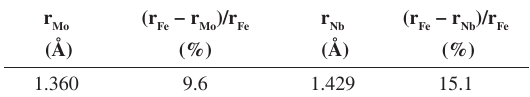
Table 1. Atomic radius of the elements (r size mismatch with the Fe atomic radius.